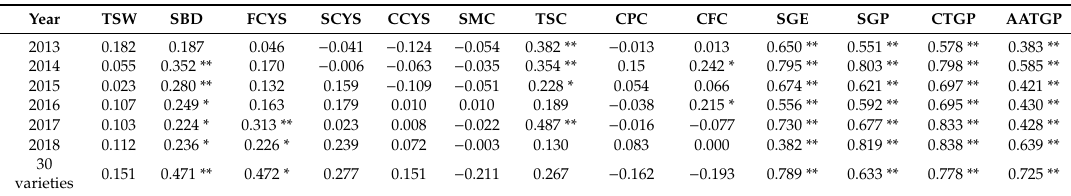
Table 4. Relationships between seed physical and chemical indices, seed germination indices, and mean field seedling emergence